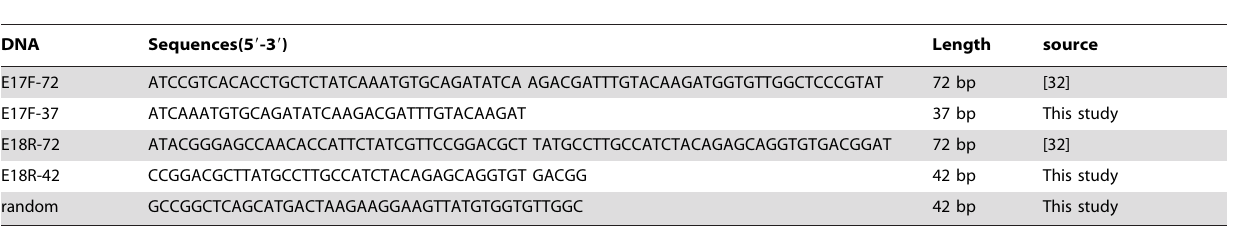
Table 3. The sequence of LPS-binding aptamers and random DNA.